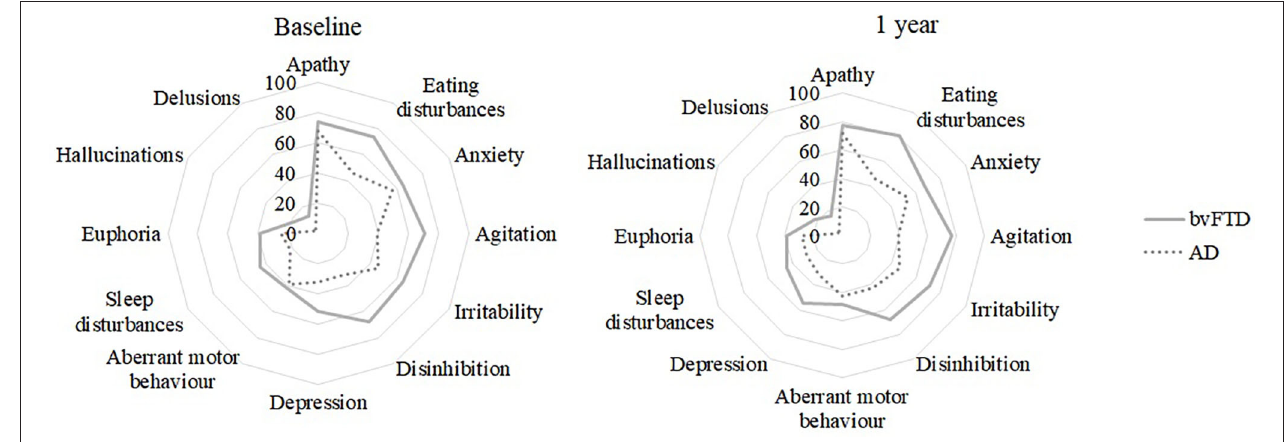
FIGURE 1 | Frequency (%) of patients with neuropsychiatric symptoms (baseline and 1-year follow-up) for each clinical group.